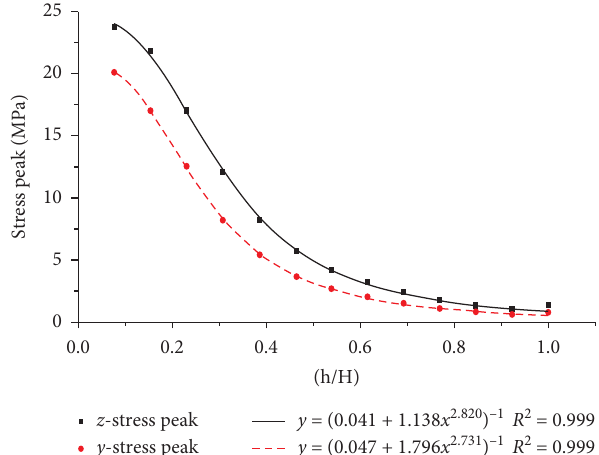
Figure 14: Distribution of the axial and radial stress peaks.